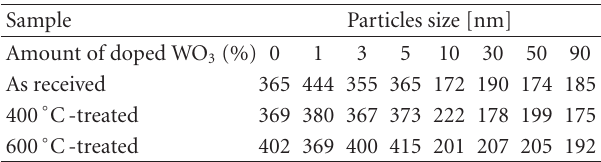
Table 1: Particles size of photocatalysts measured by DLS method. Sample